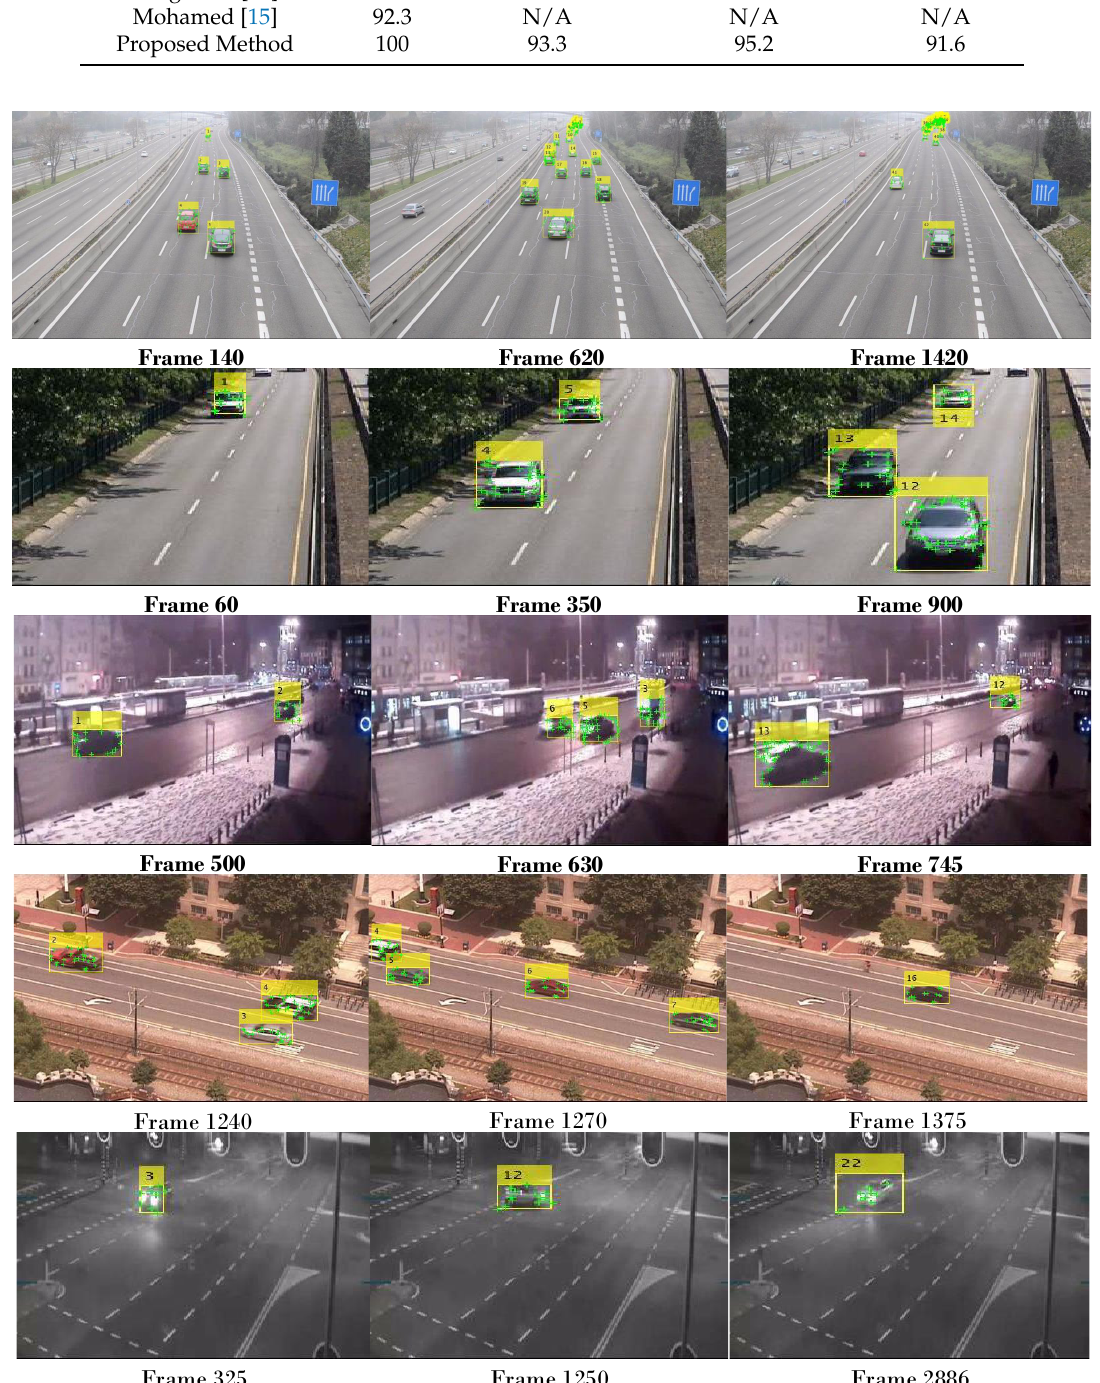
Figure 8. Sample results on GRAM and CDnet2014 dataset. Top row: Cloudy and crowded. Second and fourth row: Waving trees. Third and Bottom row: Night scene with changed